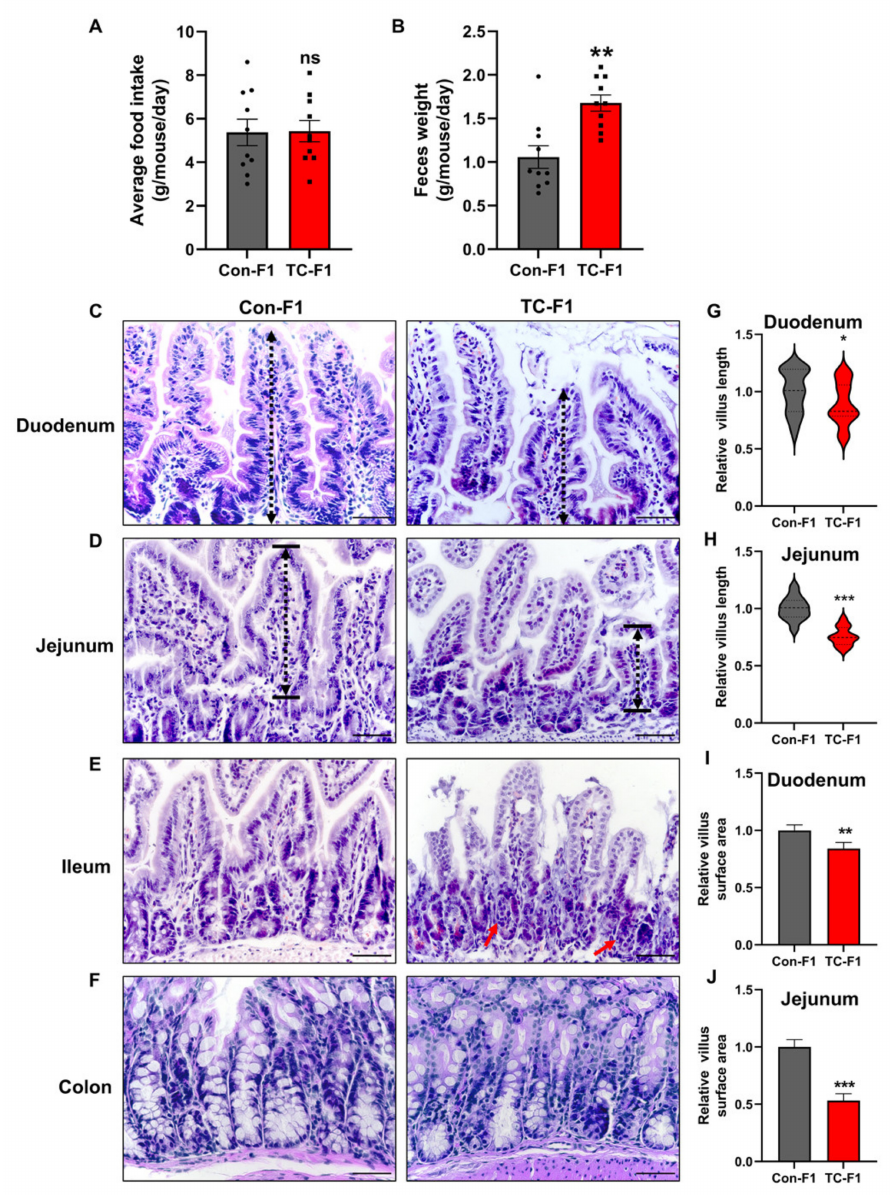
Figure 3. Maternal TC exposure affects small intestinal morphology in 8-week-old F1 female mice. ( A ) Average daily food intake of 8-week-old F1 female mice. ( B ) Average daily fecal production of 8-week-old F1 female mice. n = 10. ( C – F ) Representative HE images of the duodenum ( C ), jejunum ( D ), ileum ( E ), and colon ( F ) of 8-week-old offspring female mice. Black dashed lengths represent intestinal villi lengths and red arrows represent inflammatory cell aggregates. Scale bar = 50 µ m. ( G , H ) Relative duodenal ( G ) and jejunal villus length ( H ). ( I , J ) Relative villi surface area of the duodenum ( I ) and jejunum ( J ). Data are presented as mean ± SEM. * p < 0.05; ** p < 0.01; *** p < 0.001 vs.